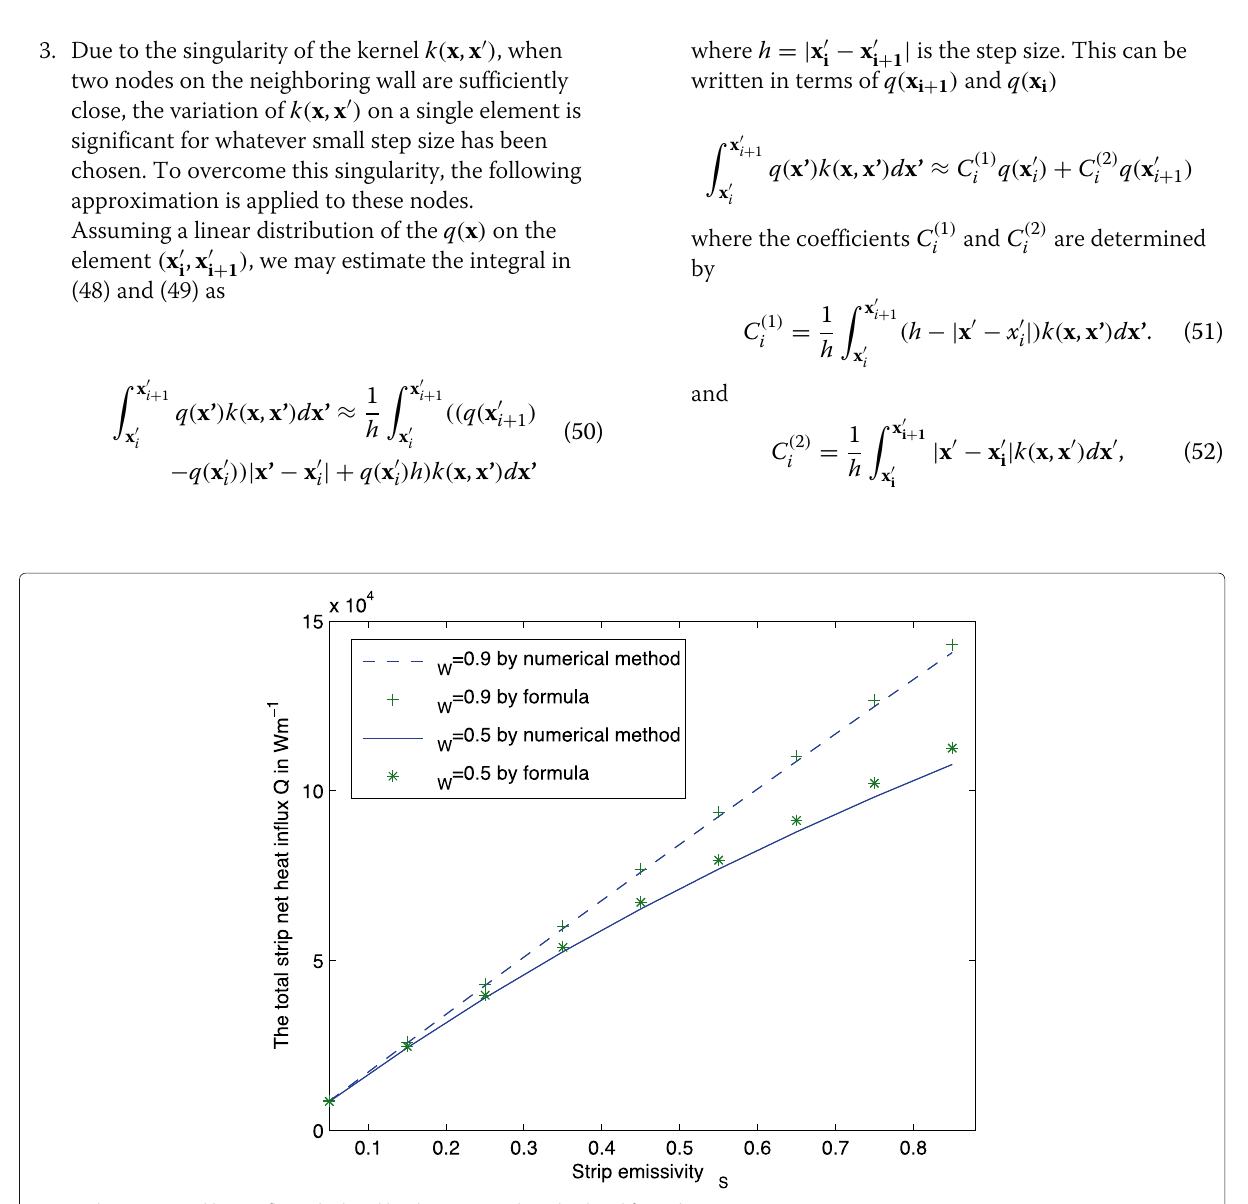
Fig. 7 The strip’s total heat influx calculated by the numerical method and formula